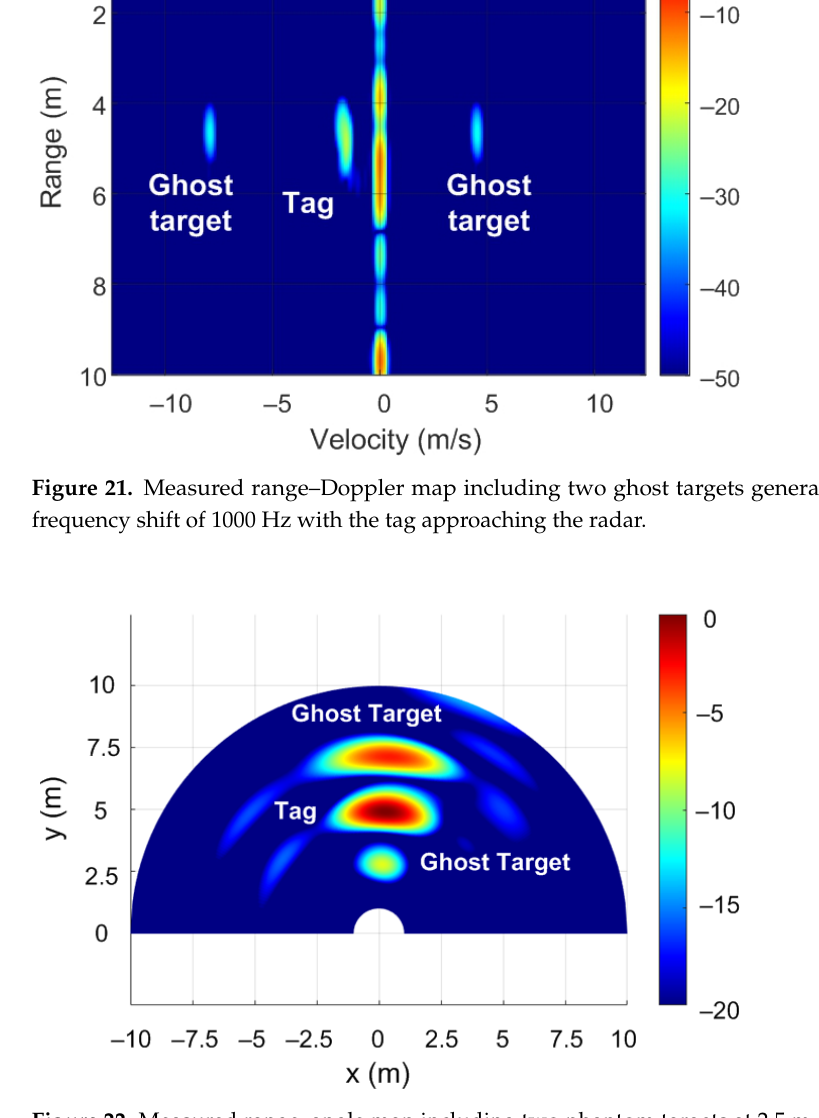
Figure 22. Measured range–angle map including two phantom targets at 2.5